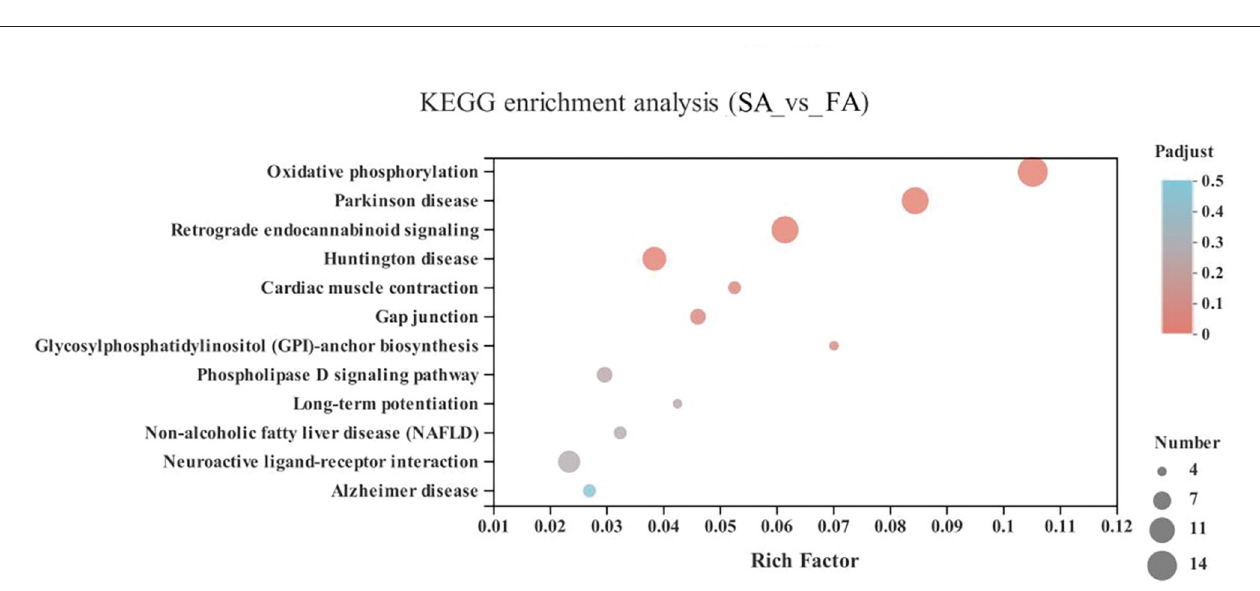
FIGURE 7 | KEGG pathway enrichment analysis of differentially expressed genes (DEGs) between SR and FR groups. SR, slow-growing dual-purpose chickens feed restriction; FR, fast-growing broilers feed